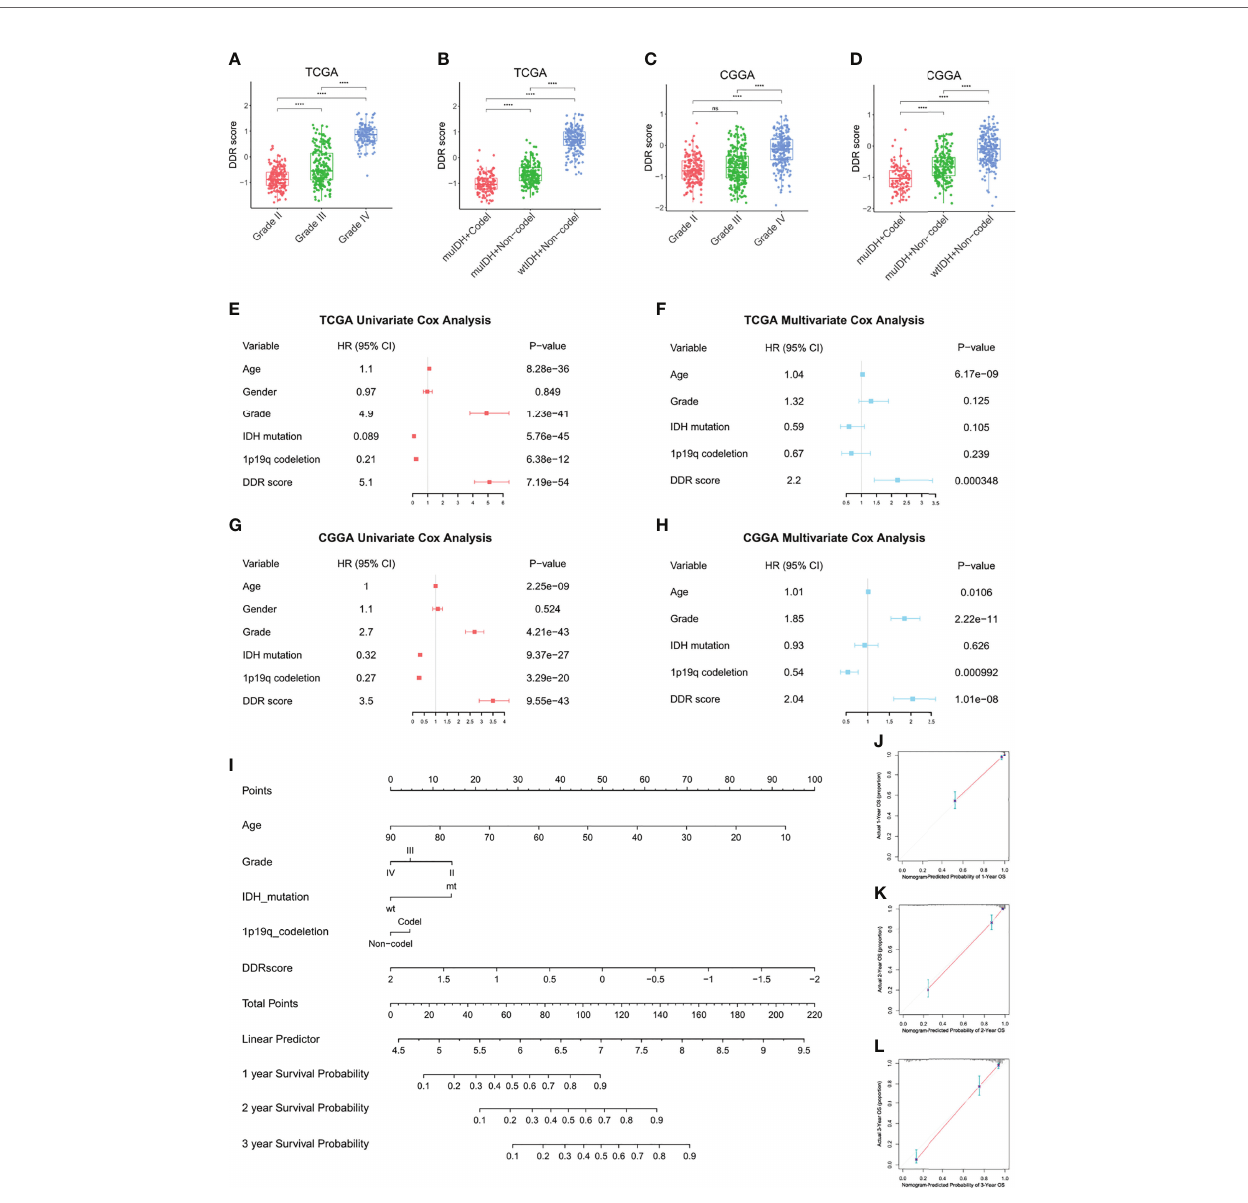
FIGURE 3 | DDR score was an independent prognostic factor among other clinical parameters. (A – D) The DDR scores were compared between patients with different malignancy grades and clinicopathological statuses in TCGA (A, B) and CGGA (C, D) . (E – H) Univariate and multivariate cox analyses of DDR score, tumor grade, IDH mutation status, and 1p19q codeletion status in the TCGA (E, F) and CGGA cohorts (G, H) . (I) A nomogram to predict the 1, 2, and 3 years survival probability of the TCGA cohort. (J – L) The calibration curves of the nomogram to predict the 1, 2, and 3 years survival probability. ****p < 0.0001; ns, no signi fi